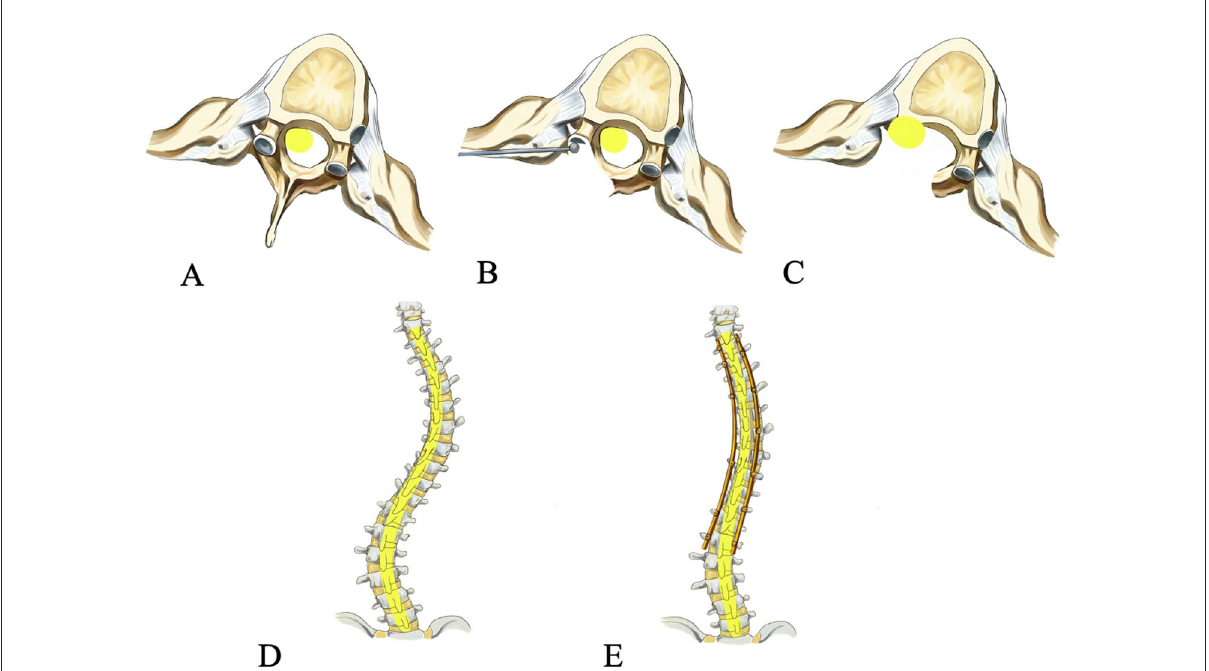
FIGURE1 Operative procedure of spinal cord transposition. The spinal cord is compressed preoperatively (A) , the wall of the spinal canal and the pedicle on the concave side at the apex of the curve is drilled (B) , the spinal cord is transposed laterally and anteriorly (C) , posterior-anterior view preoperatively (D) and post-operatively (E) .